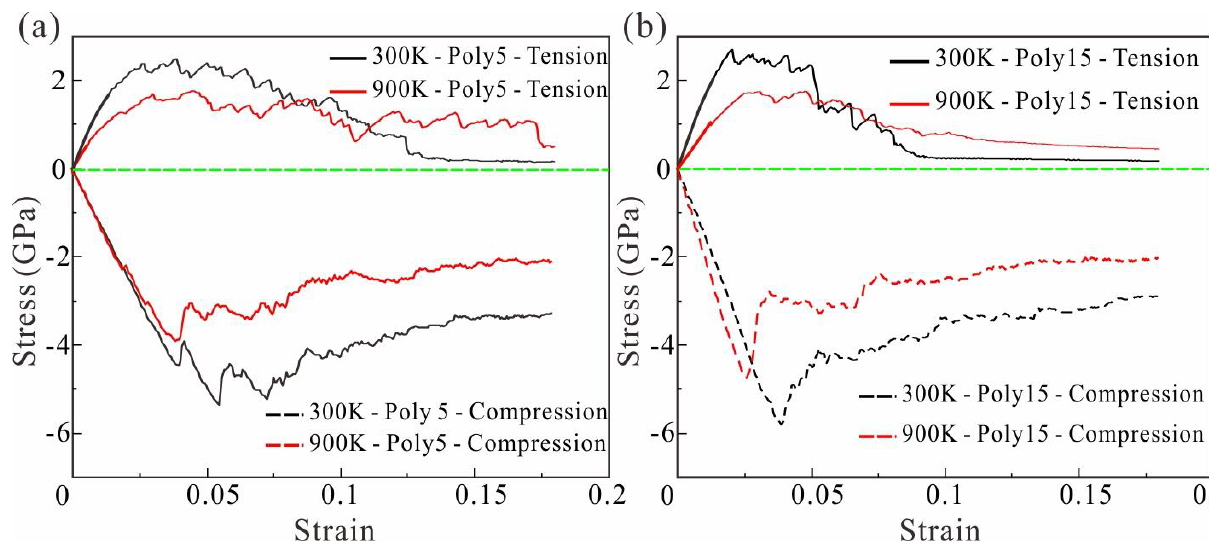
Figure 8. ( a ) Polycrystalline HEA with grain number of 5; ( b ) Stress-strain curves of polycrystalline HEA with grain number of 15 under tensile and compressive loads at 300 K and 900 K, respectively. (The green line indicates that the stress is 0 to distinguish between tension and compression). Table 4. Tensile strength, compressive strength and tension-compression asymmetry of polycrys- talline and single crystal HEAs at 300 K and 900 K.